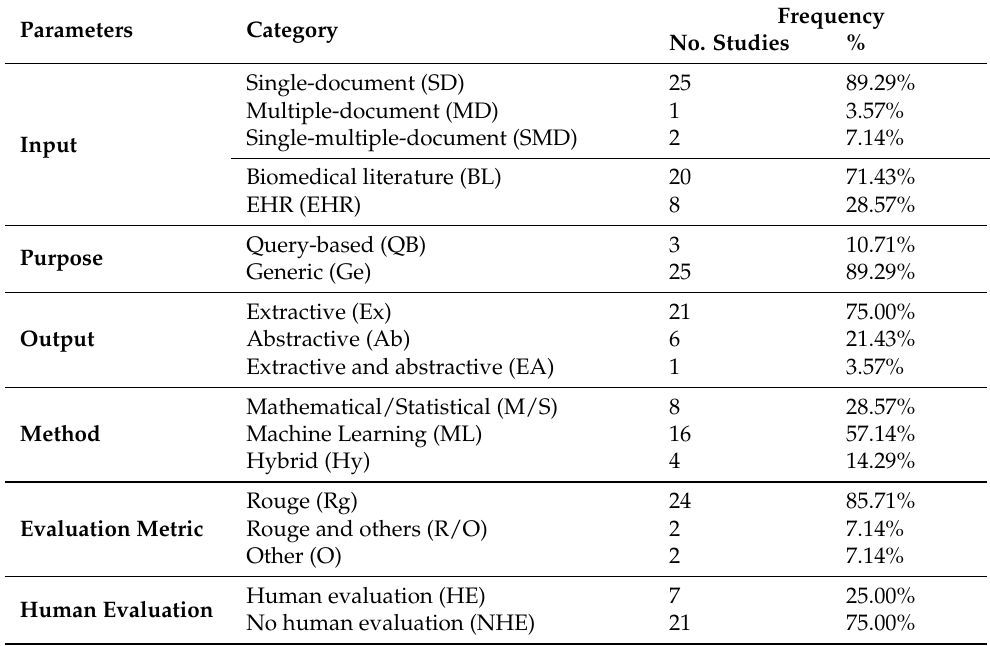
Table 5. Number and frequency of studies categorized according to summarization factors following second eligibility